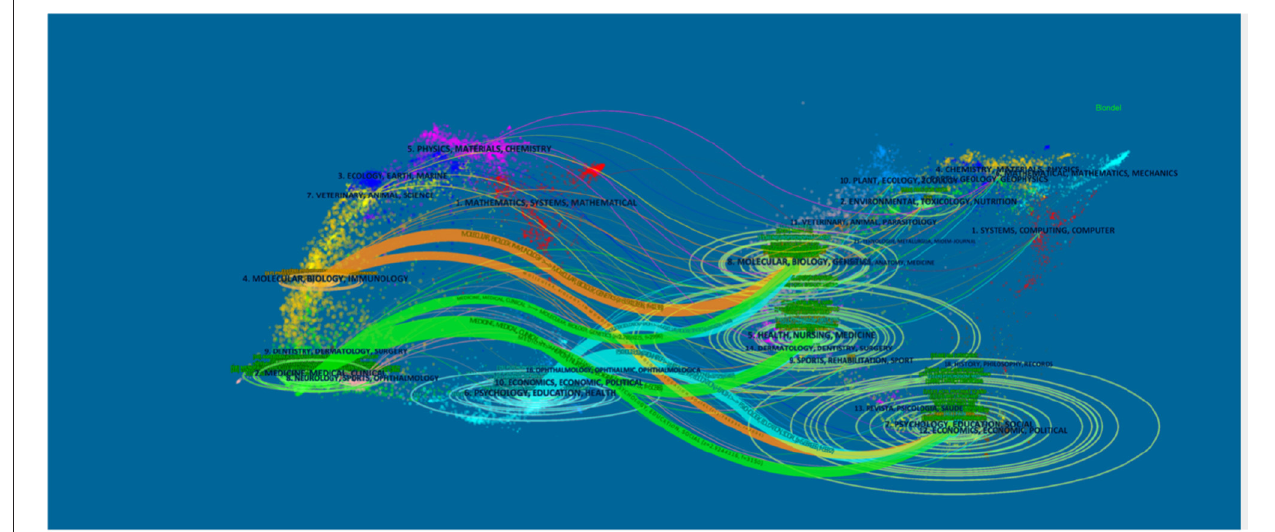
FIGURE 3 | The dual-map overlay of journals related to PMS/PMDD research. The left and right sides corresponded to the citing and cited journals maps, respectively. The labels represented the disciplines covered by the journal. The lines on the map started from the left and ended on the right, representing the citation links.